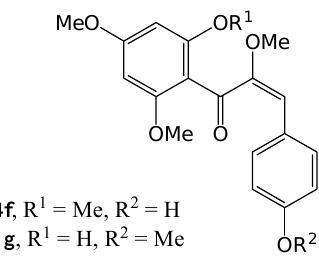
Figure 4. Structures of photochemical relatively stable 2'-hydroxy- α -methoxy- cis -chalcones